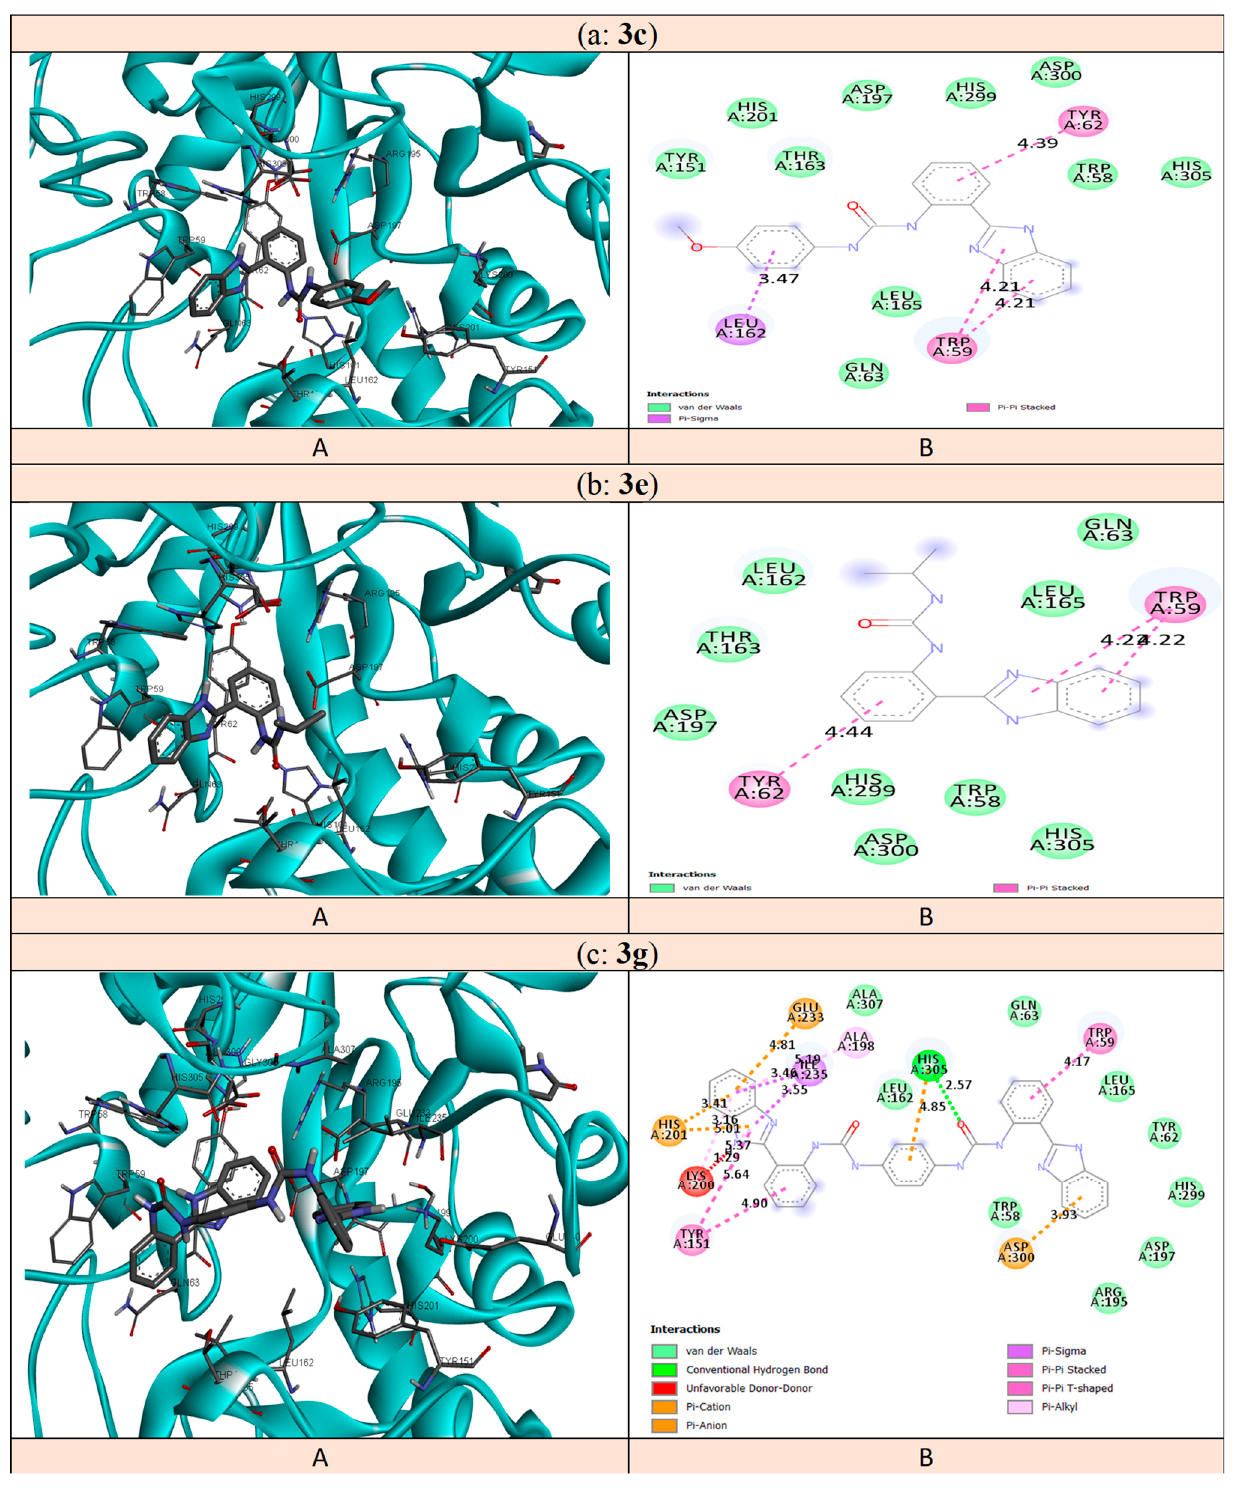
Figure 6 . The interaction types of ( a ) 3c , ( b ) 3e , and ( c ) 3g with surrounding amino acids of HPA are shown in 3D ( A ) and 2D ( B ).